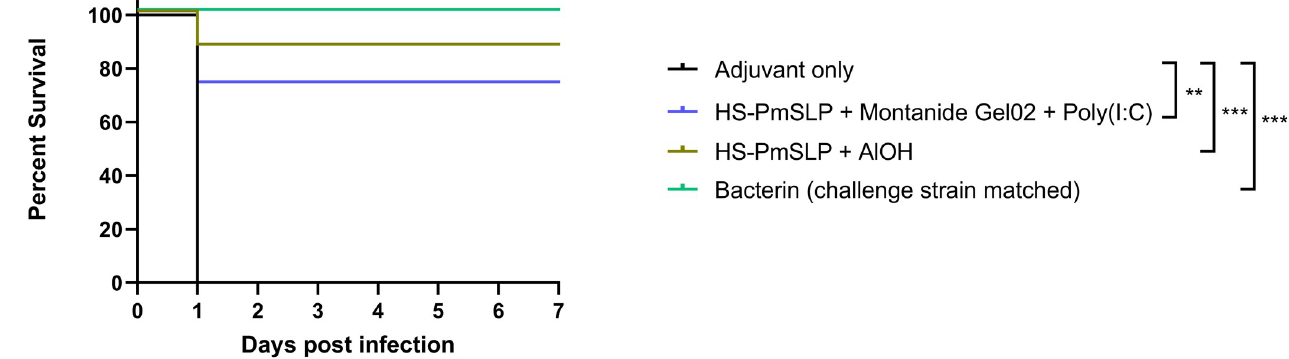
Fig 8. Survival of Zebu cattle immunized with two different HS-PmSLP vaccine formulations or the matched bacterin following a lethal challenge with a Serogroup B HS isolate. N = 8 animals per group. Log-rank (Mantel Cox) tests performed for survival curve comparisons; *** , p < 0.005; ** , p < 0.01.